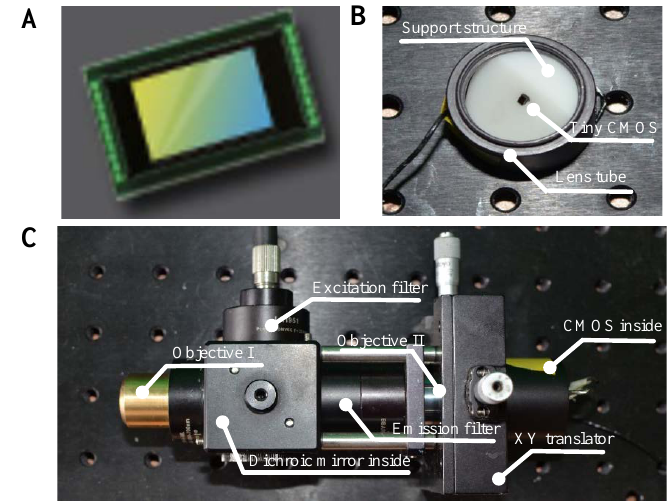
Figure 3. Photograph of the laboratory-built prototype, ( A ) image sensor [31], ( B ) the tube with image sensors mounted and ( C ) the photograph of prototype.